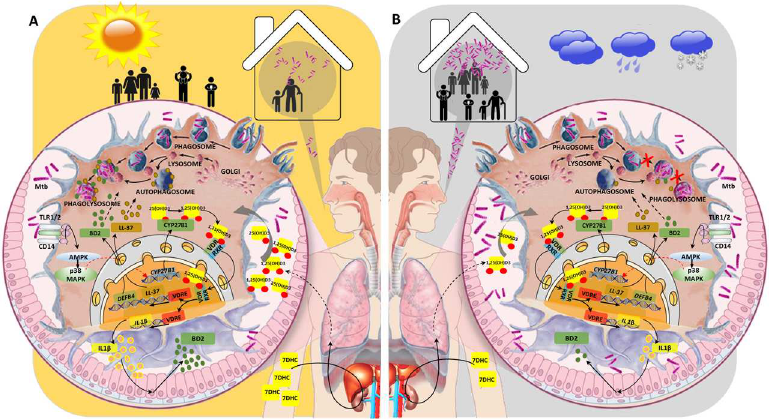
Fig 3. A schematicmodel for the impactof the seasonality and levelsof Vitamin D (VD) metabolites on the riskof being infected with M . tuberculosis and the protectivemechanisms of the immune response. ( A )Duringspring/summer season,sunnydaysfavor outdooractivities, decrease closecontactwith peoplewith TB andincreasesun lightexposure promotingenhanced skin productionof 7-dehydrocholesterol(7DHC), the precursor of activeVD, andthe synthesis of D3 metabolites first in liverandthenin kidney.The mainproduction of 1,25-dihydroxyvitaminD3 (1,25(OH)D3) occursin the kidneybut it canalsobe produced by inflammatory cells duringan immuneresponseto infections[10,11,23].Alveolarmacrophagesrecognizemoleculesassociatedwith M . tuberculosis ,suchas the mycobacteriallipoproteinLpqH,throughToll-likereceptors (TLRs) suchas TLR2/1 andthe co-receptor CD14expressedon theircell surface[20,24].Engagementof thesereceptorsinducea cell signalingpathwaythat include AMPK andp38MAPK activation,whichleadsto upregulation of CYP27B1 hydroxylase andthe conversionof 25OHDinto1,25(OH)D3 [24].Giventhat immunecellscanalsoexpressthe VD receptor(VDR),1,25(OH)D3 bindsto heterodimer formedbetweenthe VDRandthe retinoidX receptor (RXR)andtranslocateintothe nucleuswherethis transcription factor complexspecifically recognizes DNA sequences namedVD responseelements (VDRE)leadingto the productionof antimicrobialpeptides,suchas LL-37(cathelicidin) andß-defensin 2 (BD2)[24].Cathelicidininduced by 1,25(OH)D3 drivesthe eliminationof engulfedmycobacteriaby promoting fusionof autophagosomescontainingmycobacteriawith lysosomes[24,25]. M . tuberculosis infectionand1,25(OH)D3 induceIL-1ß geneexpression, whichbindsviaIL-1ß receptorto epithelialalveolar cellsto promotethe expressionof BD2. The releaseof BD2alongwith1,25(OH)D3contributes to controlmycobacterialproliferationin the macrophage[26].( B )Duringautumn/winter season,cold,cloudyand rainydayspromoteindoorlifestyleandenhancedcontactwith peoplewith TB, particularlyunderovercrowded livingconditions. Reducedsunlightexposureleadsto significantlylowskin productionof 7DHCandconsequent- ly reducedsynthesisof D3 metabolites in liverandkidney,resultingin detrimental innateimmuneresponse against M . tuberculosis .Concomitantly, reducedlevelsof cathelicidinimpairsautophagyprocess.Overall,the combinationof thesefactorswouldfavor a highersusceptibility of beinginfected.